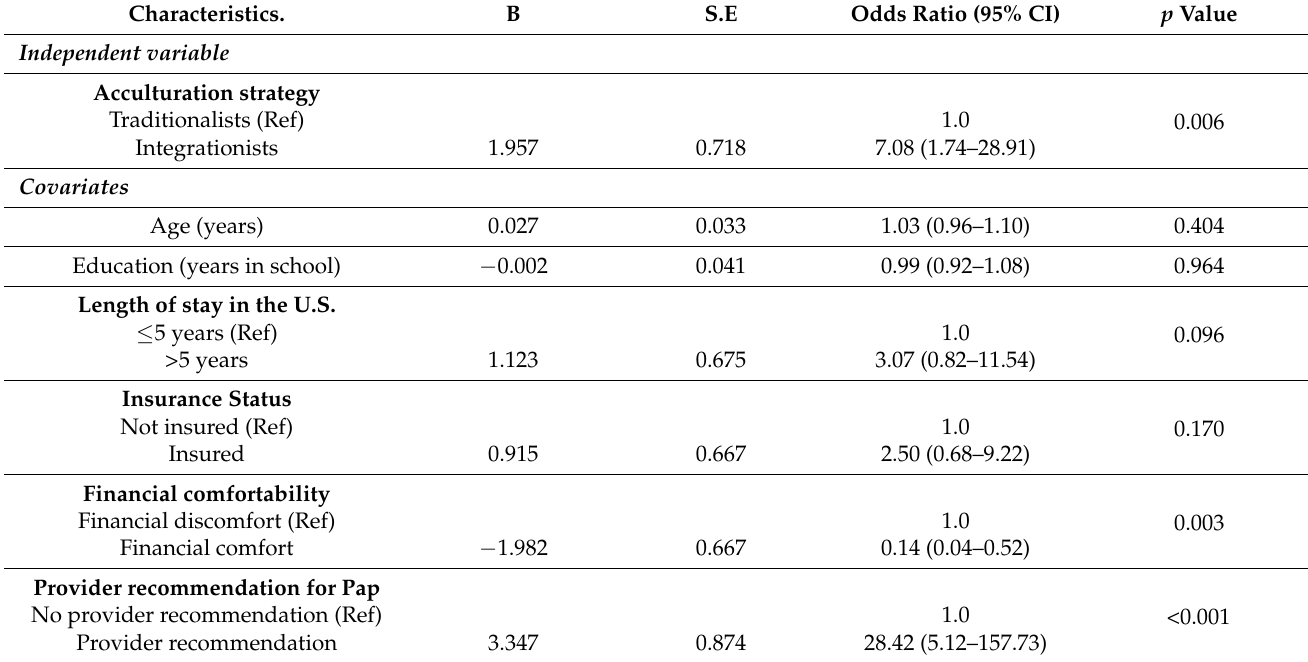
Table 2. Logistic regression model for the association between acculturation strategy and Pap Screening (N = 99). Characteristics. B S.E Odds Ratio (95% CI) p